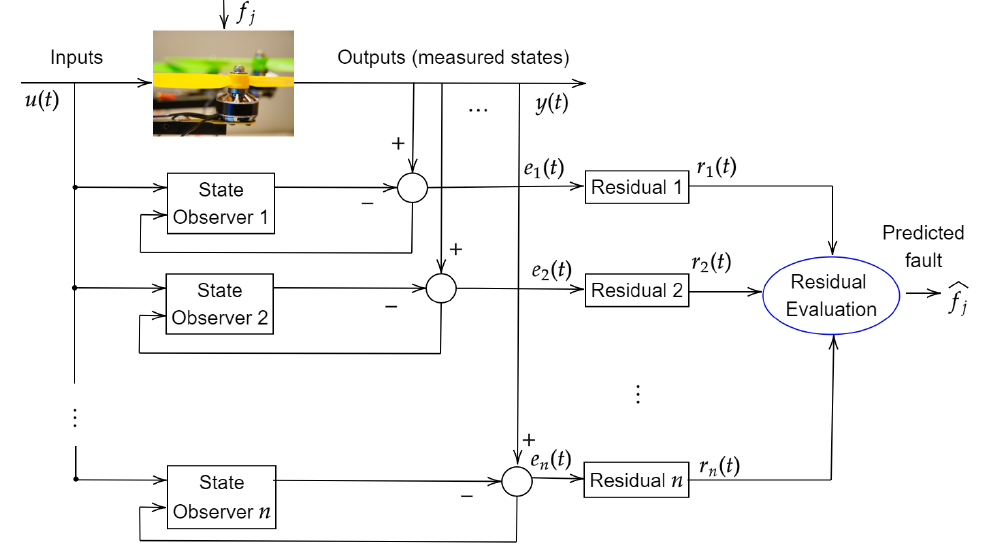
Figure 9. Bank of n observers, where u ( t ) and y ( t ) are the inputs and outputs (measured states) of the BLDC motor, respectively, e i ( t ) ( ∀ i = 1,2, . . . , n ) is the error computed by the i th observer, r i ( t ) is the residual calculated from the error e i ( t ) , f j is the type of fault affecting the system and ˆ f j is the estimated